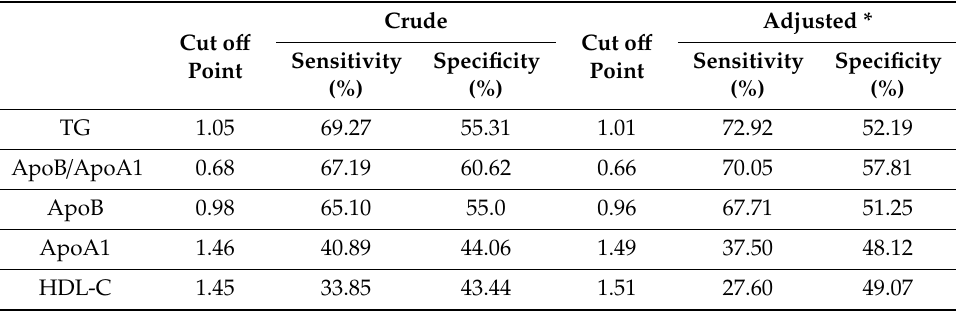
Table 5. Sensitivity and specificity of ApoB / ApoA1 ratio, TG, HDL-C, ApoB, and ApoA1 in the diagnosis of